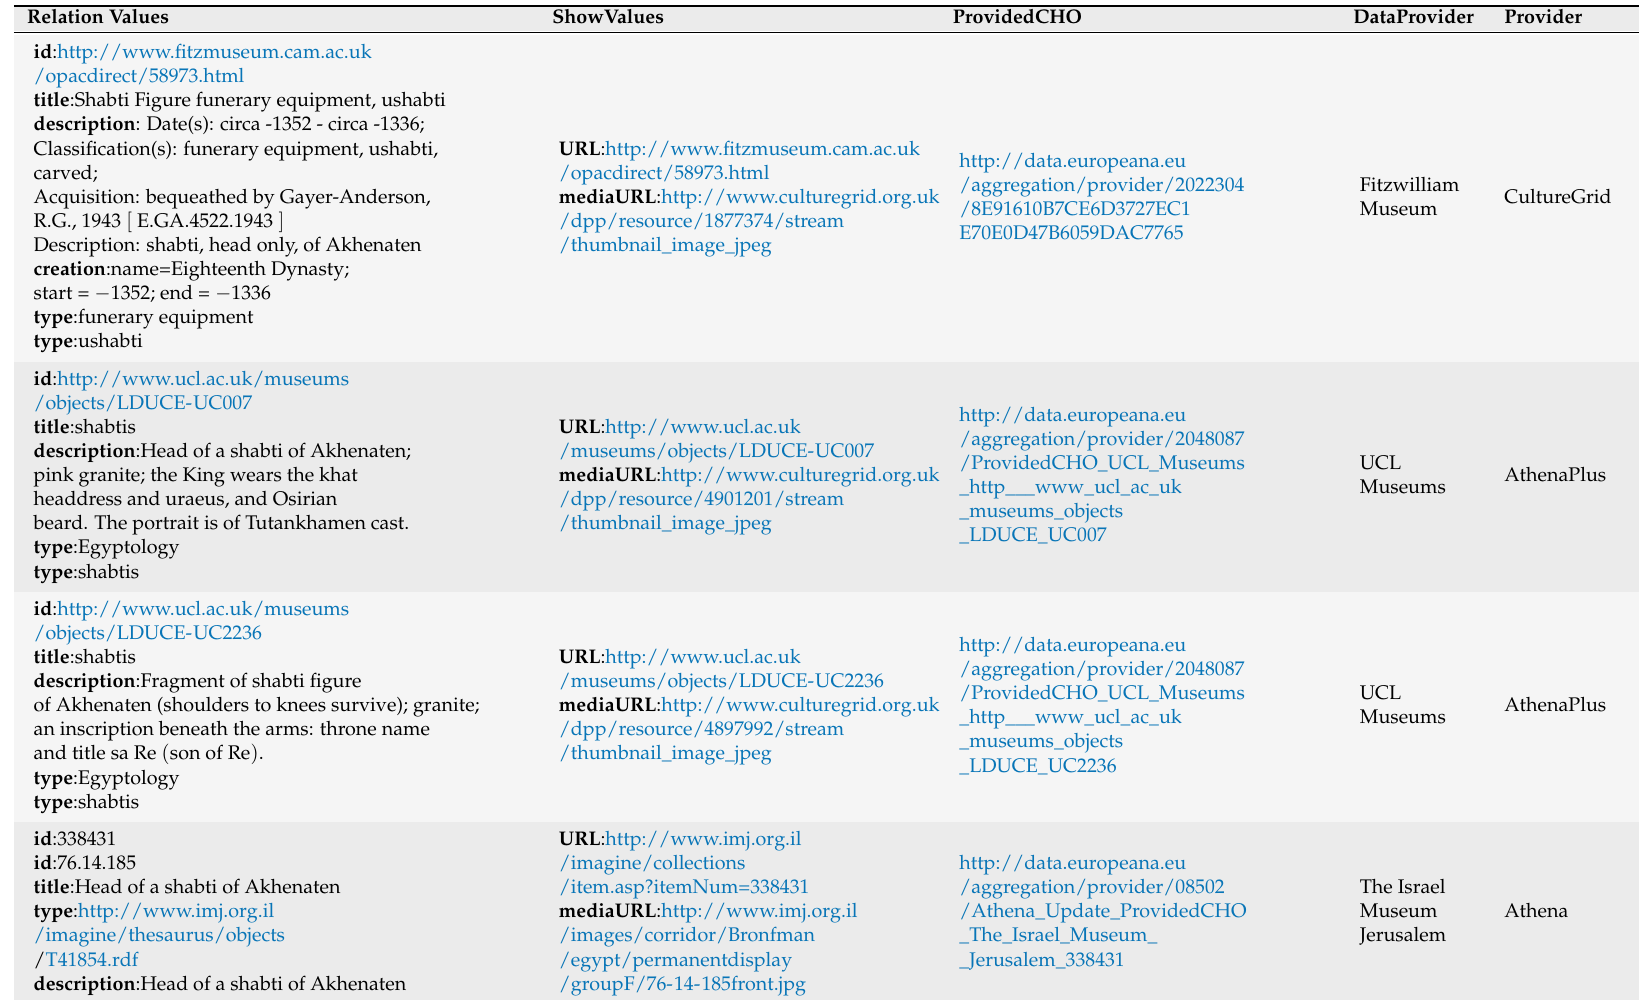
Table 6. Result of the